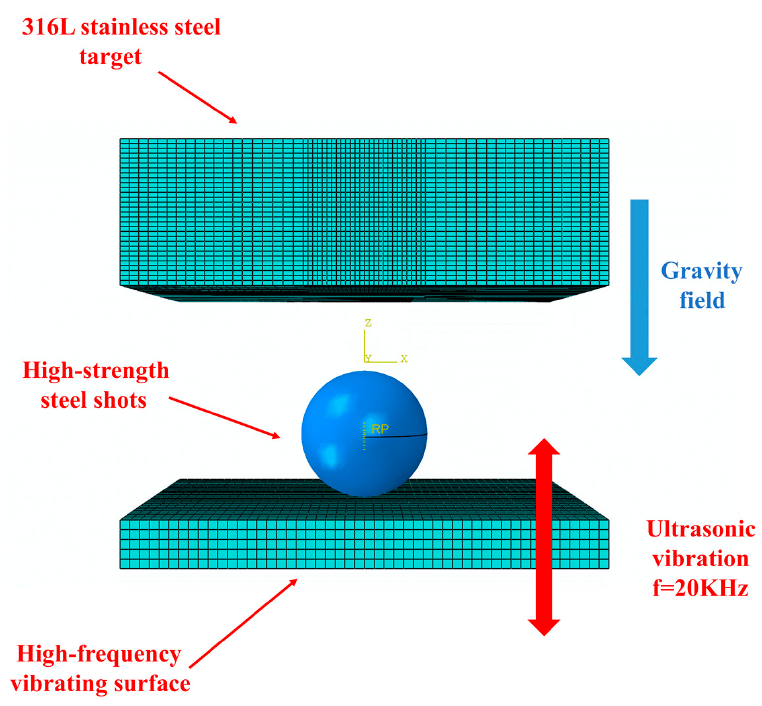
Figure 2. The finite element model to simulate the high-frequency ultrasonic shot peening process with a single shot. Table 1. The key parameters for the FE simulation of the ultrasonic shot peening process with a single shot.